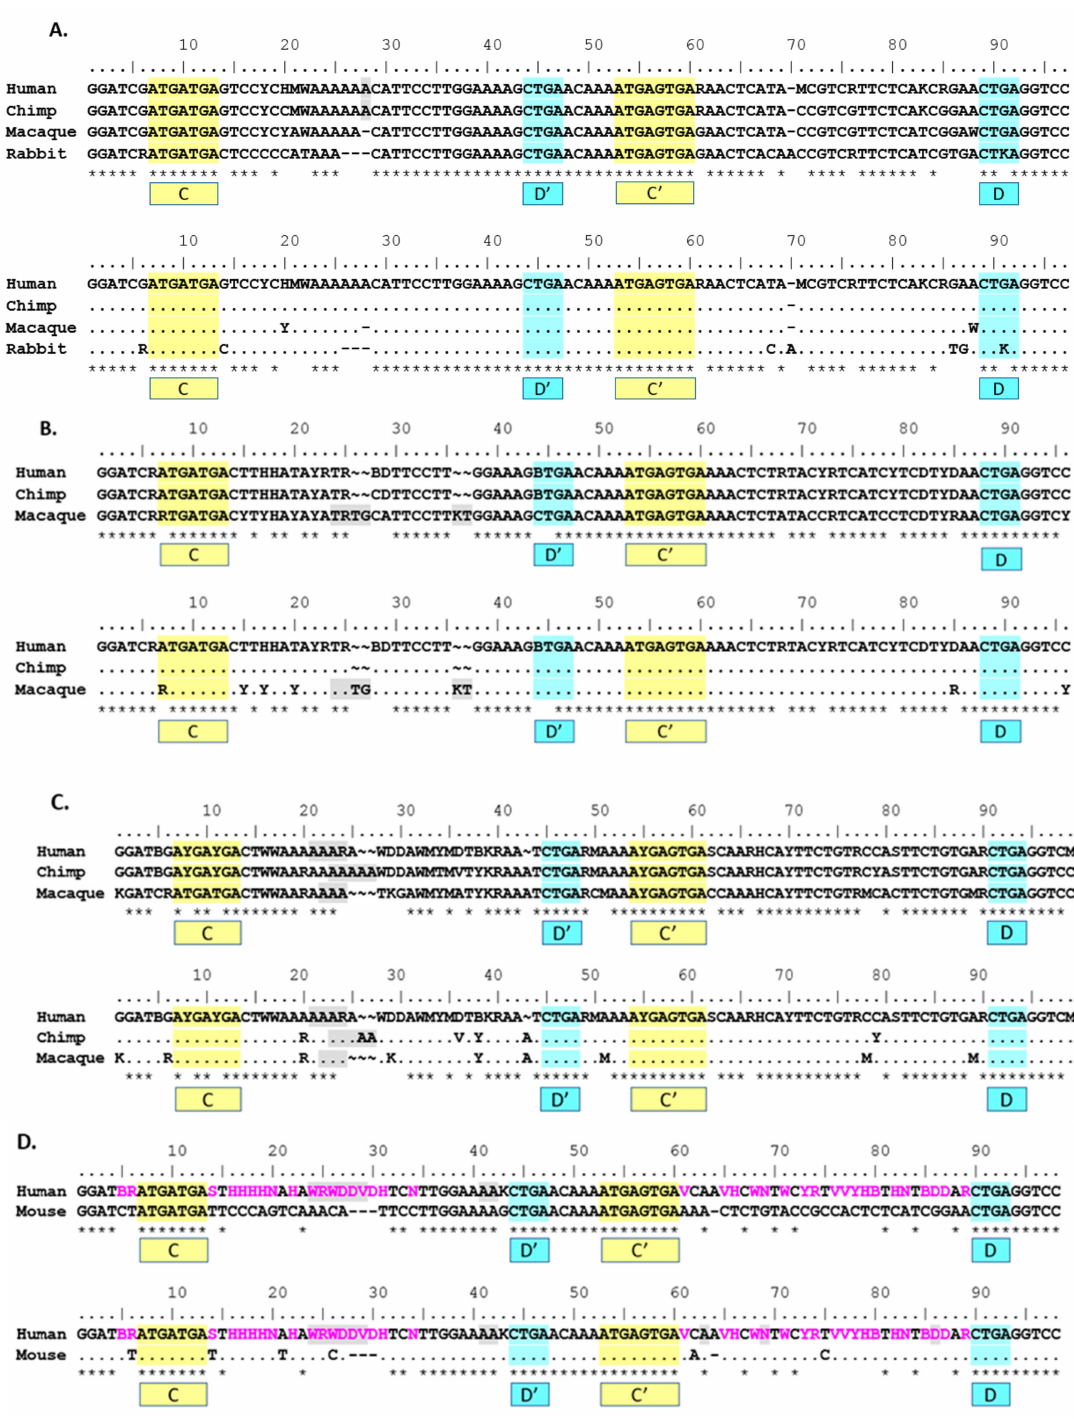
Figure 2. Consensus sequences for respective SNORD116@ transcript clusters (groups). Threshold frequency for single nucleotide inclusion in the consensus is 90%. Nucleotides that do not meet or exceed the 90% frequency threshold are indicated using IUPAC ambiguity codes. In/del sites are highlighted in light gray. Frequency for qualifying as in/del site is 10% or greater. C/C’ boxes highlighted in yellow. D/D’ boxes highlighted in light blue. A dot (.) indicates non-strict homology with human sequence for the given nucleotide position. A tilde (~) indicates a gap in consensus sequence compared to other consensus sequences. An asterisk (*) indicates perfect homology with the human sequence for all nucleotides in the site above. ( A ) Group I consensus analysis; ( B ) Group II consensus analysis; ( C ) Group 3 consensus analysis; ( D ) Mouse-human consensus analysis. For this analysis, nucleotides using IAPUC codes are